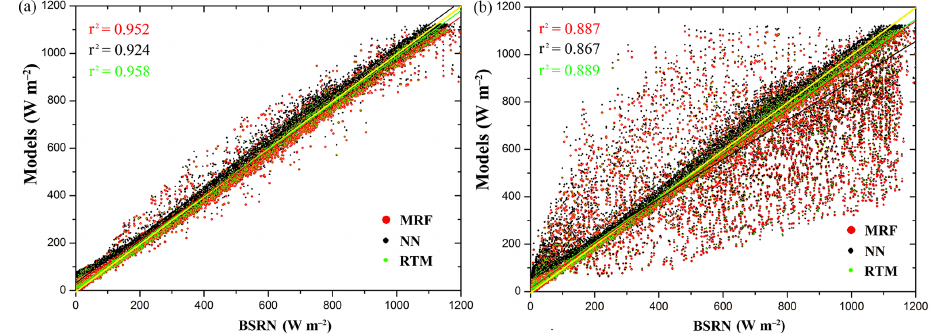
Figure 8. Scatterplots of real-time (MRF and NN) and RTM-simulated GHI in Wm − 2 as compared to the BSRN measurements for all stations under clear-sky (a) and all-sky (clear-sky and cloudy) conditions (b) .